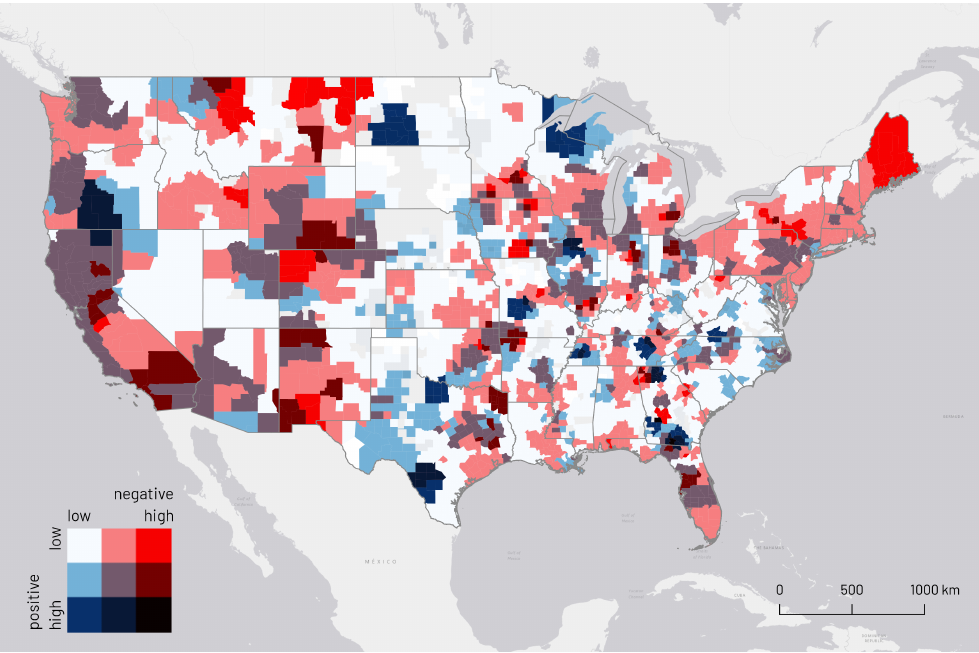
Figure 5. Bivariate map of negative and positive hot spots after the Twitter acquisition (27 October–23 November 2022). Counties without Tweets are